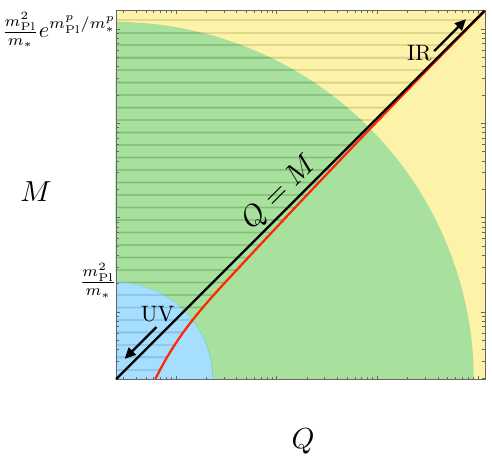
Figure 1 . Mass and charge parameter space for black holes (both plotted logarithmically). The unperturbed extremality line, at Q = M in Planck units, is modified by higher-derivative operators to a new curve (red). We explore this curve in two regimes: the asymptotic IR (yellow), where the extremality condition is dominated by corrections induced by running of the Wilson coefficients from massless loops, and the threshold region (green), where the leading corrections are the finite coefficients induced by integrating out massive particles parametrically lighter than the Planck scale. The boundaries between these regions are stated for a completion of the higher-derivative operators at scale m ∗ . Black holes occupy the striped region, and we argue that the mass/charge curve always bends below the M = Q line for healthy theories, thus satisfying the